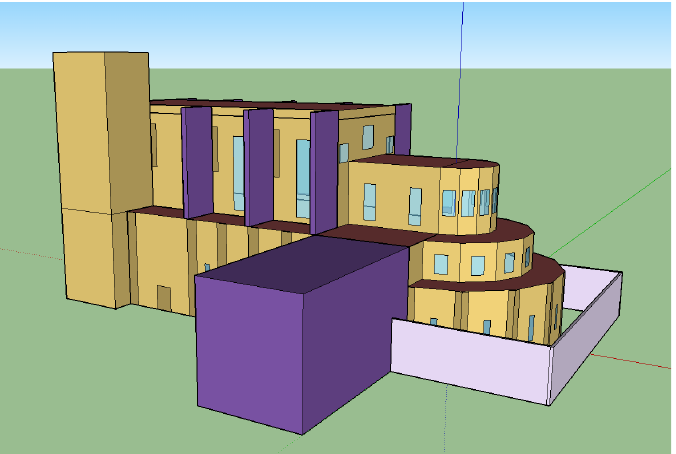
Figure 12. View of the South façade of the cathedral. Own elaboration with SketchUp.